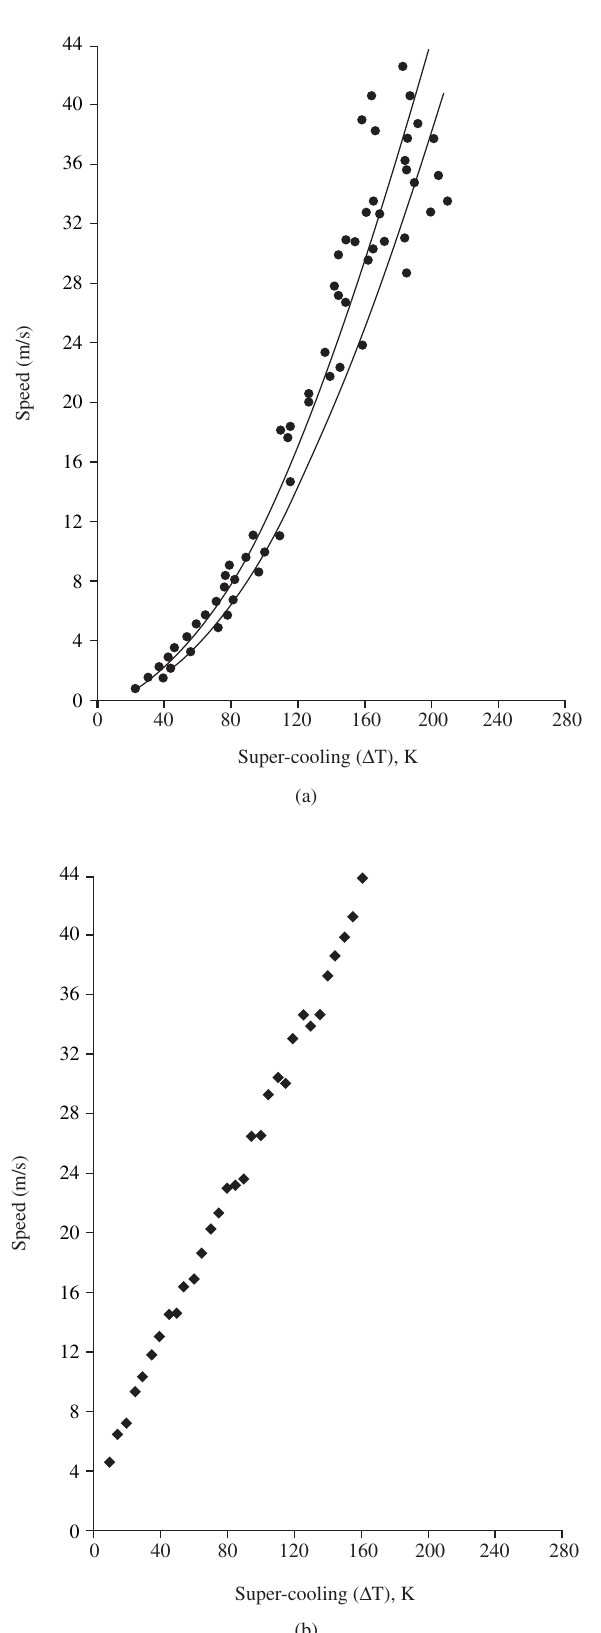
found in the secondary and tertiary arms; side branching occurs